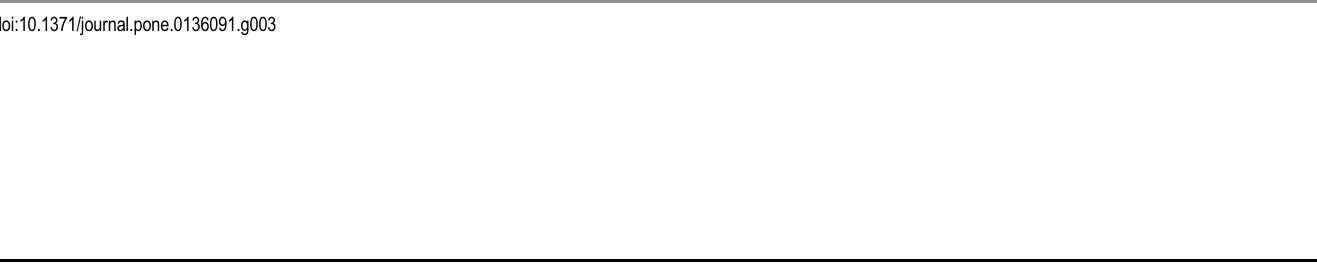
PLOS ONE | DOI:10.1371/journal.pone.0136091 August 19,